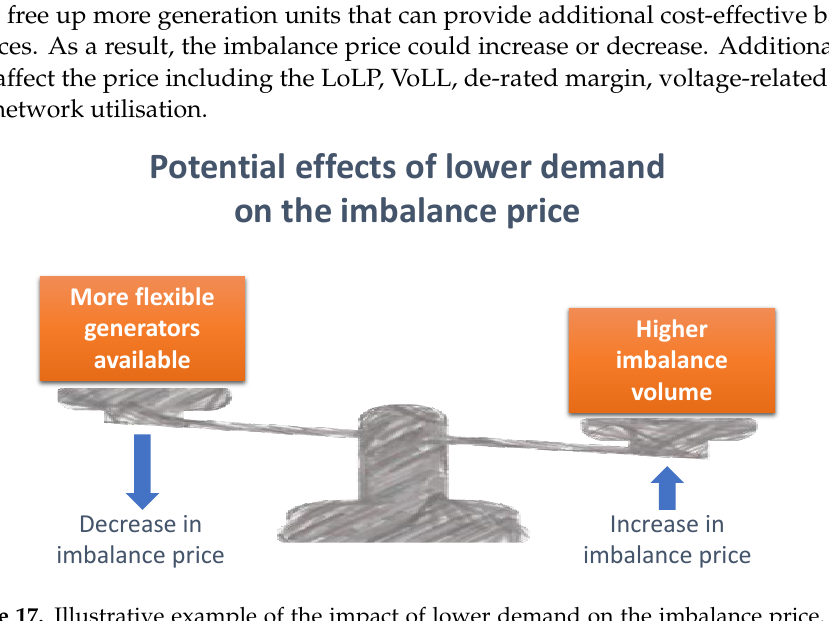
Figure 17. Illustrative example of the impact of lower demand on the imbalance price. Multiple factors impact the imbalance price in different ways. One effect that reduces the imbalance price is that more flexible conventional plants are available due to the lower demand and higher RES share. In contrast, the observed higher imbalance volume increases the price as the more expensive resources must be used (similar to merit